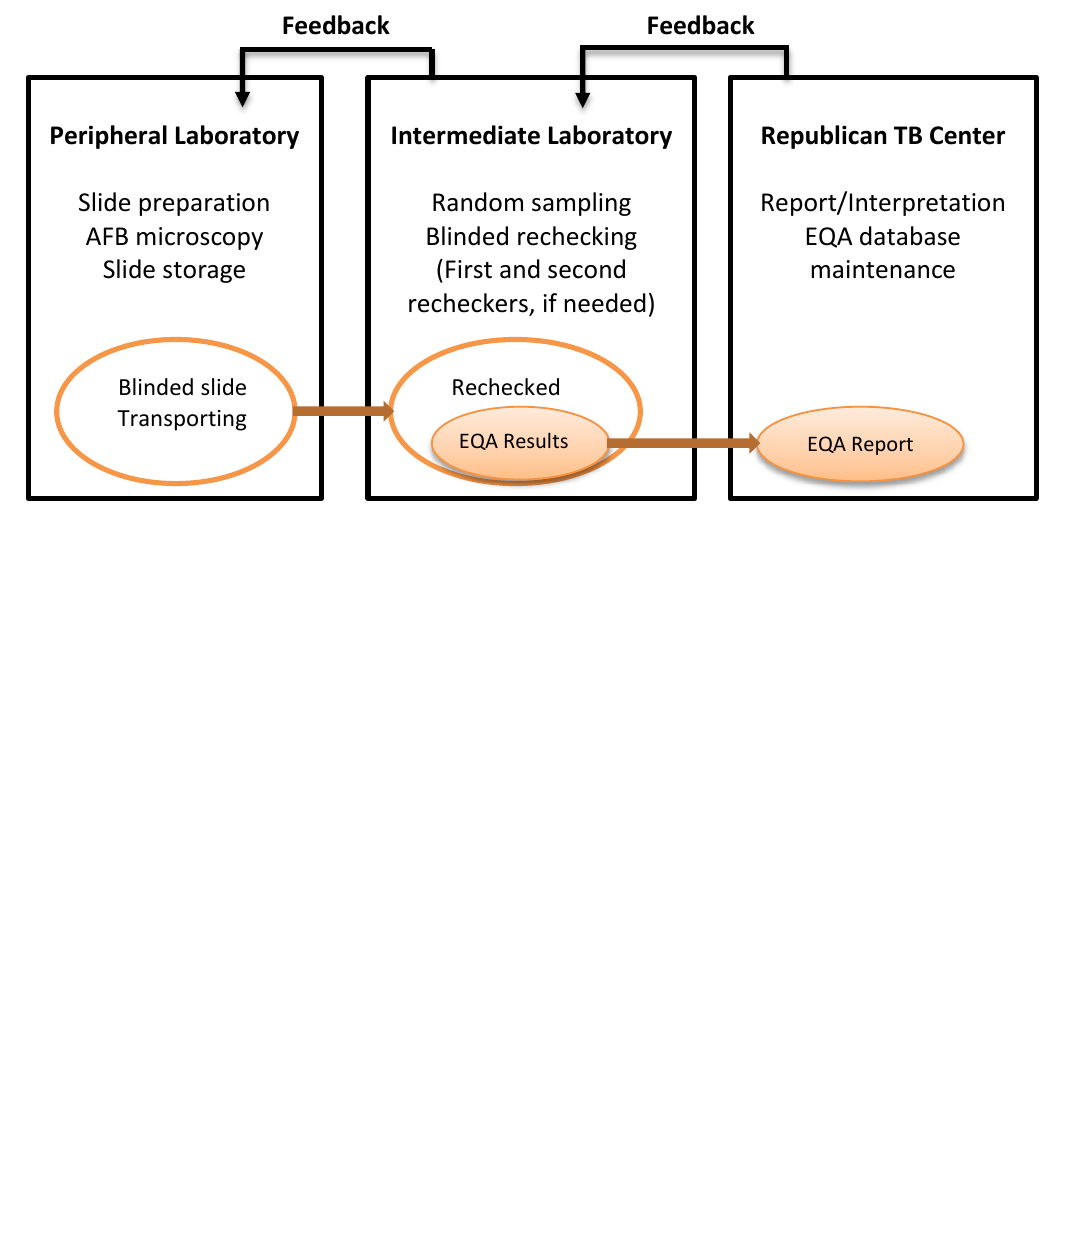
Figure 1: Algorithm of stepwise rechecking of the EQA system in Sughd